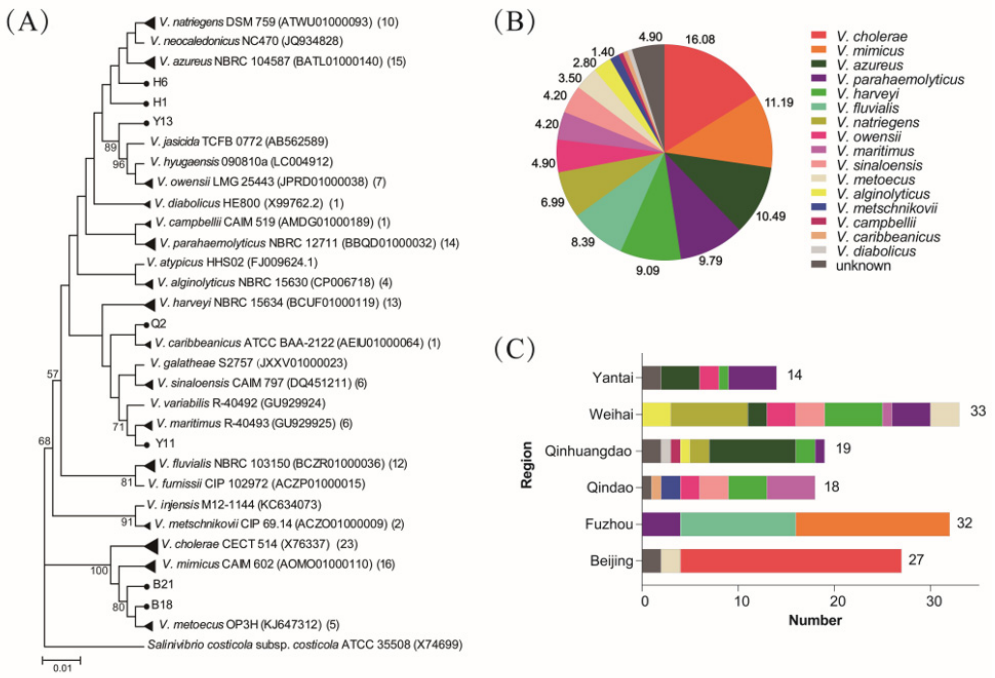
Figure 1. The Vibrio species composition and regional distribution: ( A ) the phylogenetic tree recon- structed by neighbor-joining method based on genes of 16S rRNA. Vibrio type strains were involved and accession numbers of 16S rRNA sequences were shown in the adjacent parentheses. Strain number of tested strains for each compact cluster (black triangle) was shown in the final parentheses. Unclassified tested strains were indicated by black circles. Bootstrap values were calculated from 1000 replications and values >70% were shown at branch points. Bar and value estimated nucleotide substitutions per site. The type strain of Salinivibrio costicola subsp. costicola ATCC 33508 was served as an outgroup; and ( B ) species composition (%) of Vibrio isolates. ( C ) Regional distribution of Vibrio isolates.